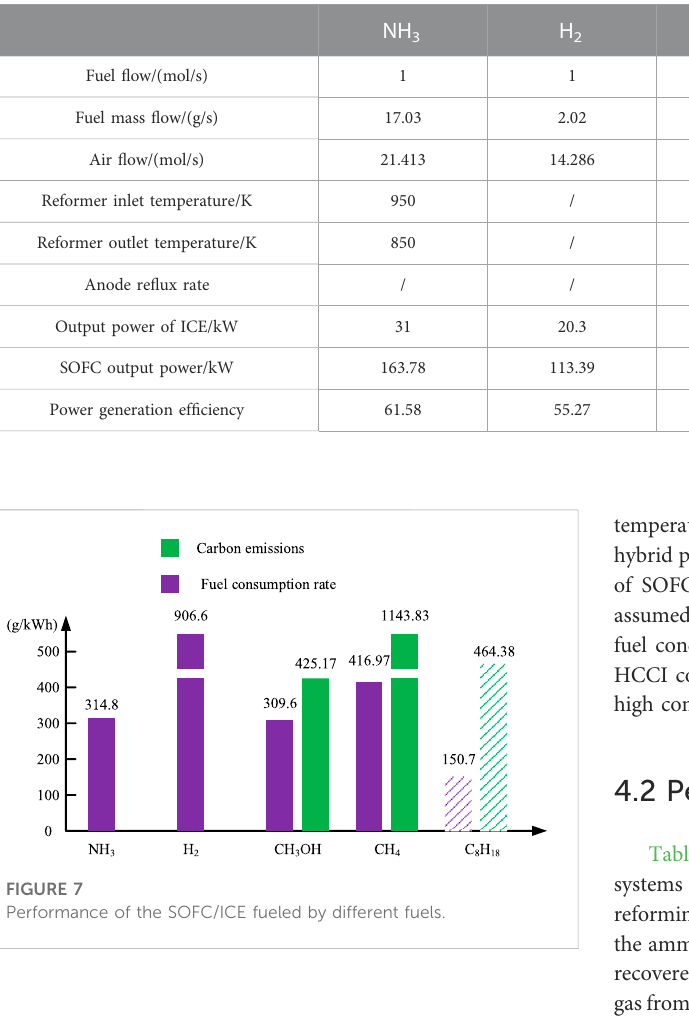
TABLE 5 Calculation results of hybrid power system.